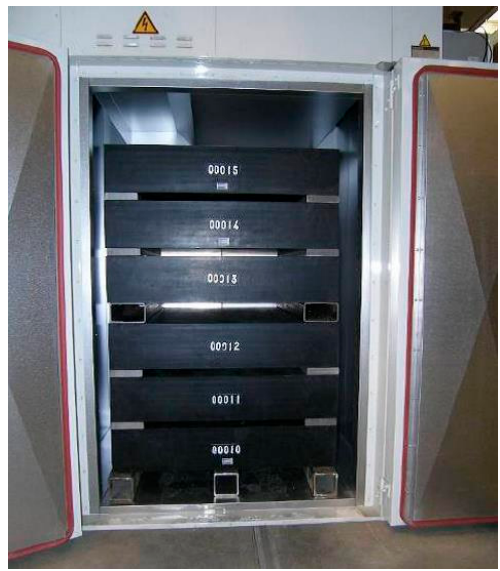
Figure 4. Aging test of a bearing [15].